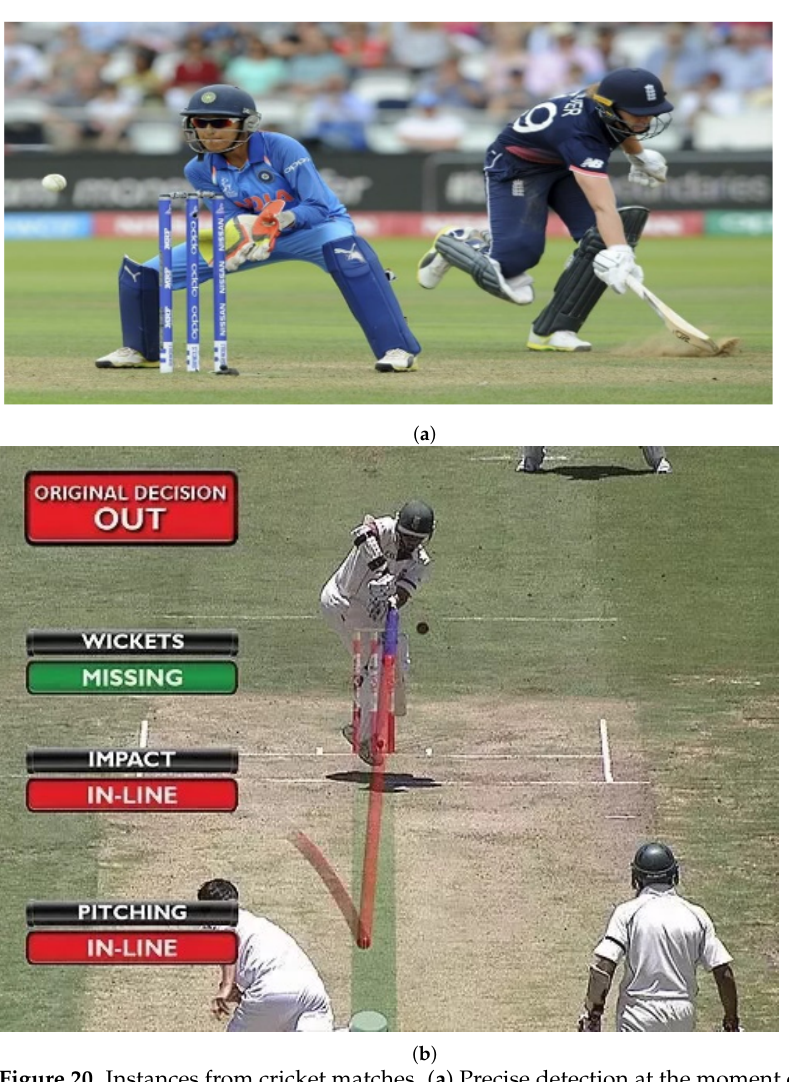
Figure 20. Instances from cricket matches. ( a ) Precise detection at the moment of run outs. ( b ) Pre- dicting the trajectory of the ball in-line or out-line, etc.